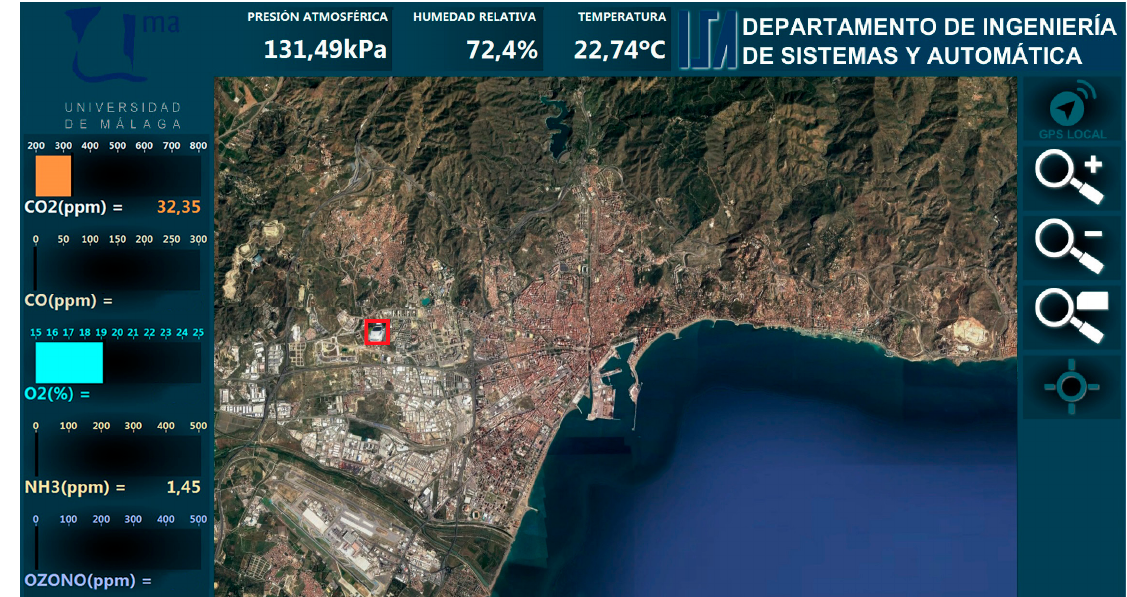
Figure 10. Human – Machine Interface for the Urban Information System. Figure 10. Human–Machine Interface for the Urban Information